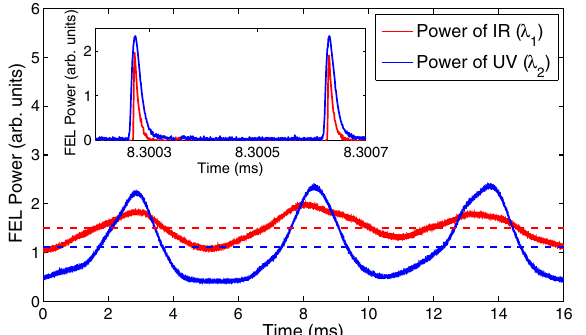
FIG. 13. Short-term (16 milliseconds) power data of the two- color FEL beams in the three-undulator configuration (Run 2). The sampling rate is 1 GS = s. Two micropulses with the sepa- ration of about 358 ns (equal to the electron revolution period) are shown in the inset. In the main figure, the macropulse structure is shown by plotting the peaks of all the micropulses. The horizontal dashed lines show the mean power of each color. The rf detune is − 0 . 4 Hz, and the beam current is about 16 mA.